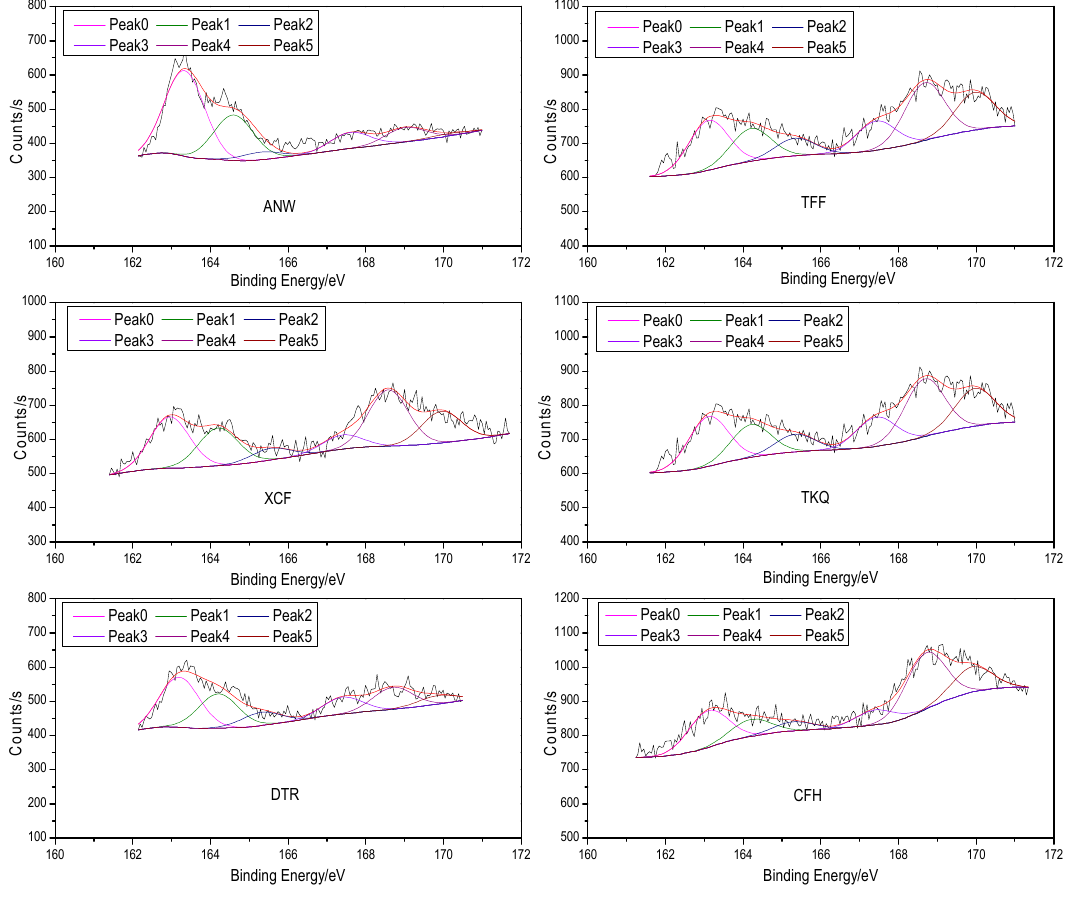
Figure 1. The XPS S 2p fitting curve of six raw coal samples.